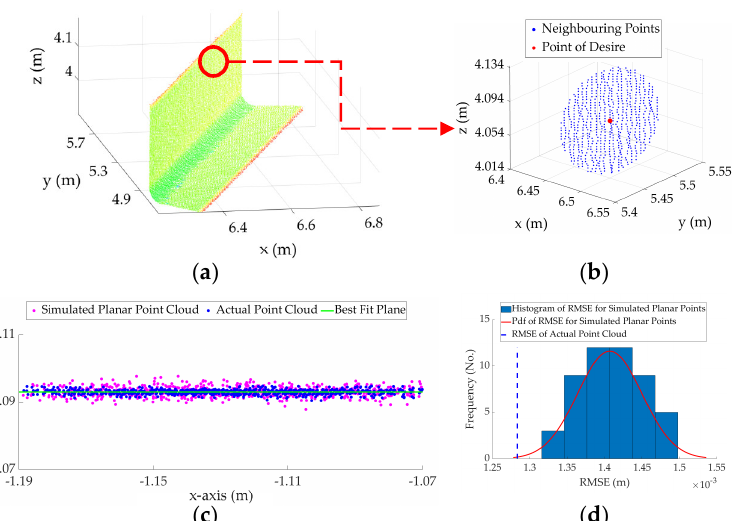
Figure 9. Sample of the planar hypothesis testing using Algorithm 2, applied to a planar neighborhood: ( a ) point cloud; ( b ) neighborhood of a point of desire; ( c ) best-fit plane (green), actual neighborhood points (blue), and simulated neighborhood points (magenta), rotated such that the plane’s normal vector is parallel to the y axis; and ( d ) distribution of the root mean squared er- Equation (2), indicating that the point follows a planar